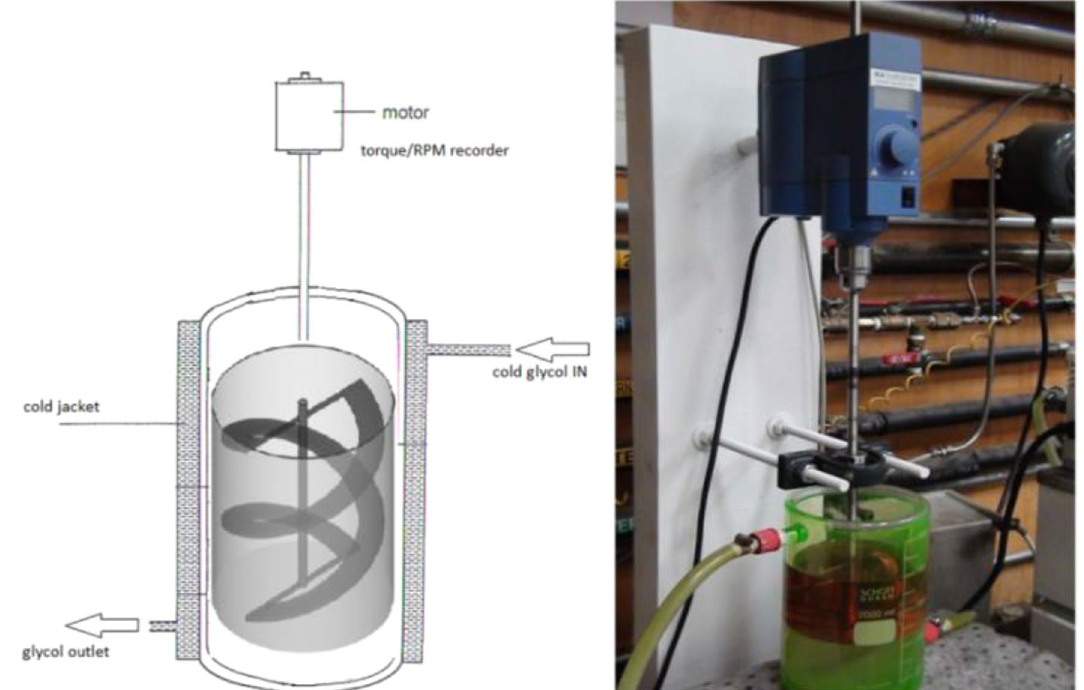
Fig. 1 Prototype setup used for the feasibility studies with cyclopentane (Bbosa